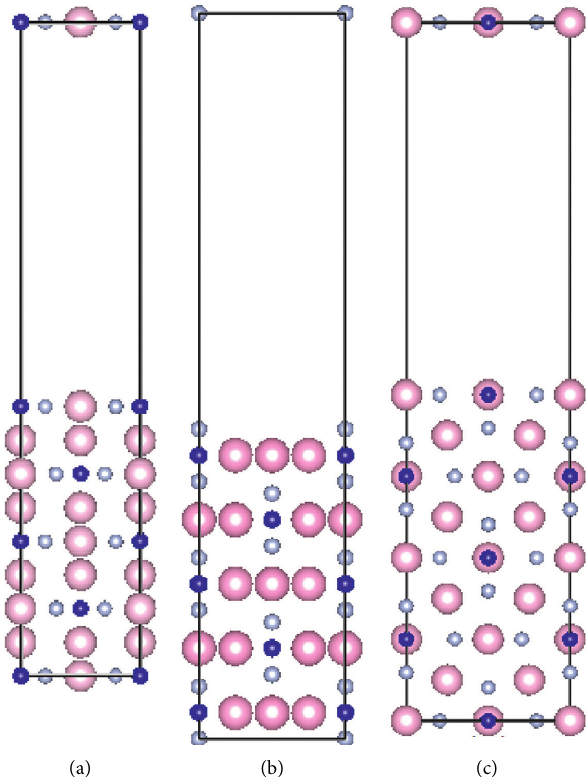
Figure 3: Schematic view of supercells for Li 3 BN 2 along the < 001 > axis: (a) (001) slab with 9 layers, (b) (100) slab with 15 layers, and (c) (110) slab with 11 layers. The gray and blue spheres represent B and N atoms, respectively, and the big pink spheres represent Li atoms.